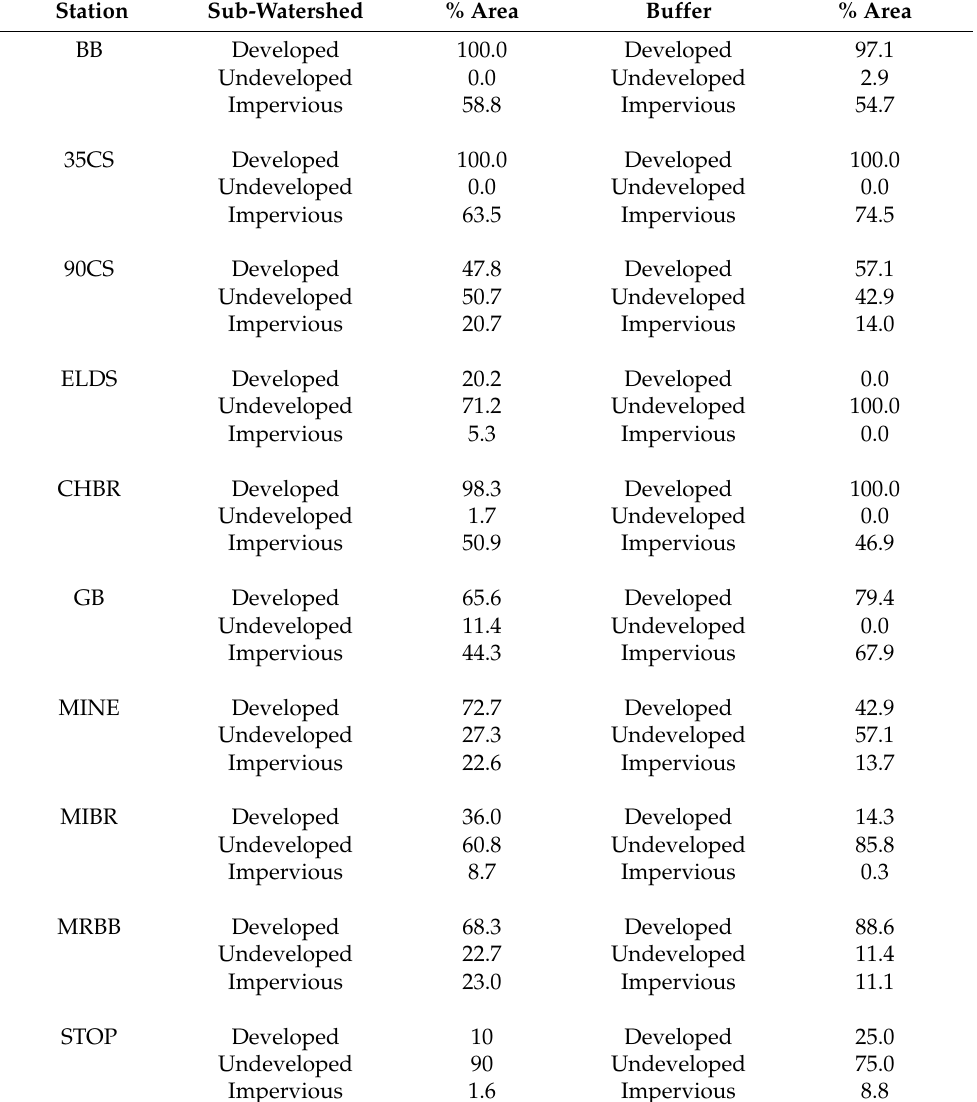
Table 4. Percentages of impervious cover and aggregated LULC classification data for each station as a percentage of total area at the sub-watershed and buffer